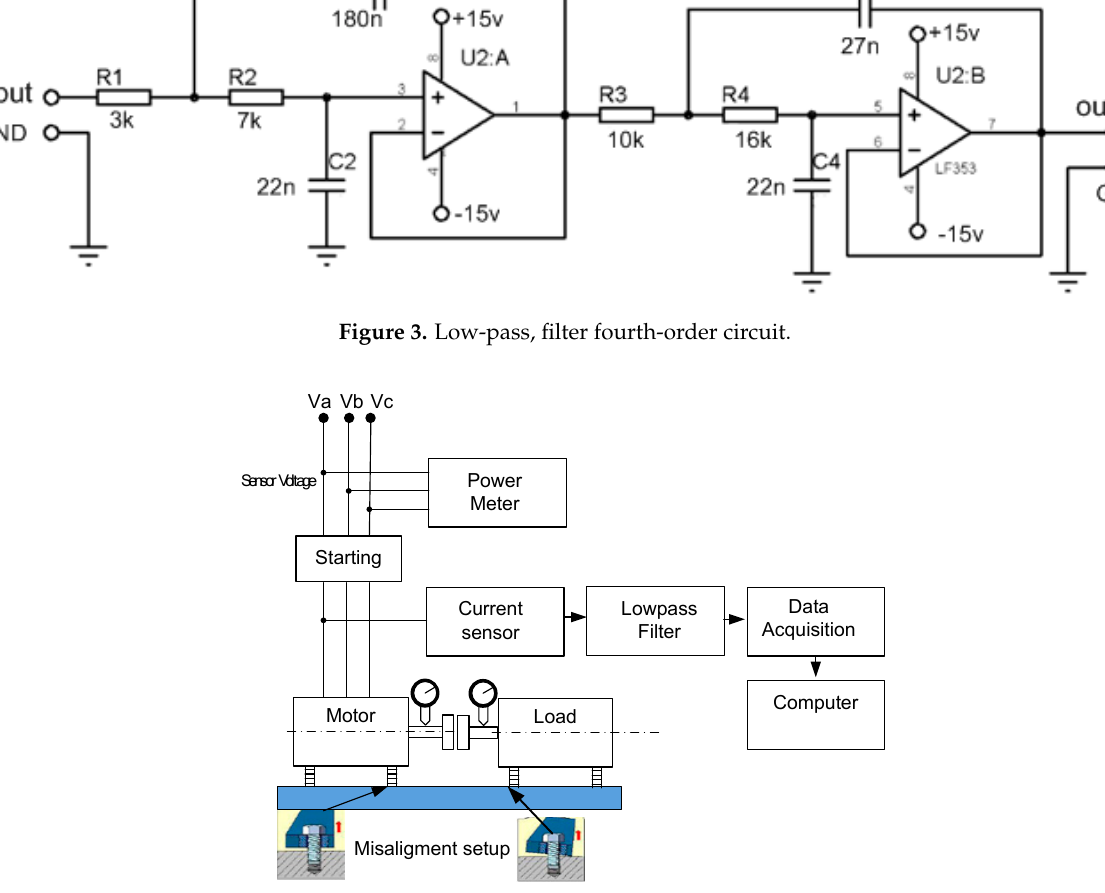
Figure 3. Low-pass, filter fourth-order circuit.